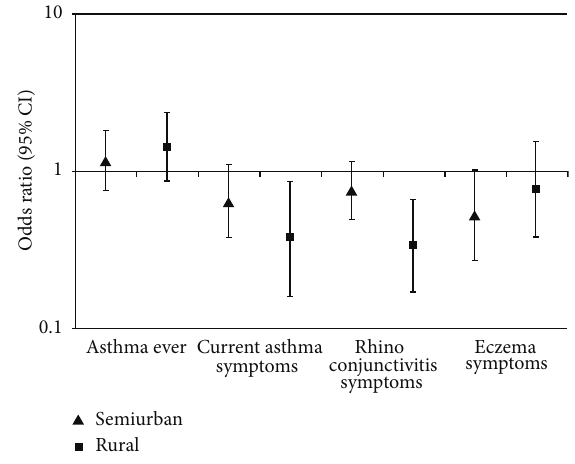
Figure 1: Odds ratio (adjusted for sex and current smoking) with 95% confidence interval by residential sector (Reference =